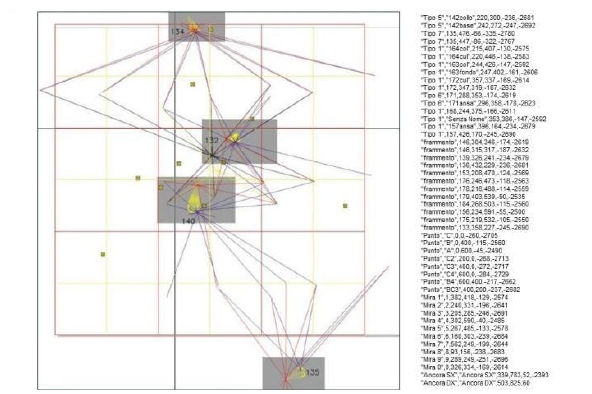
Figure 13. 2012 documentation: